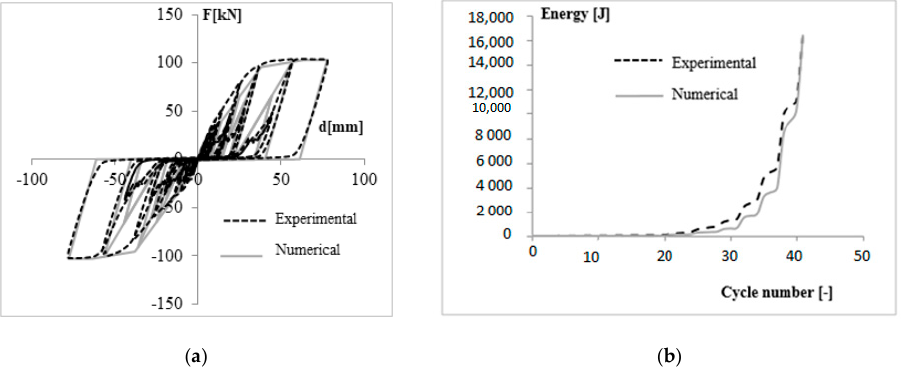
Figure 3. Modelling options and parameters used [42]. ( a ) Force-Displacement response of wall at third floor; ( b ) Cumulative energy dissipation of wall at third floor.